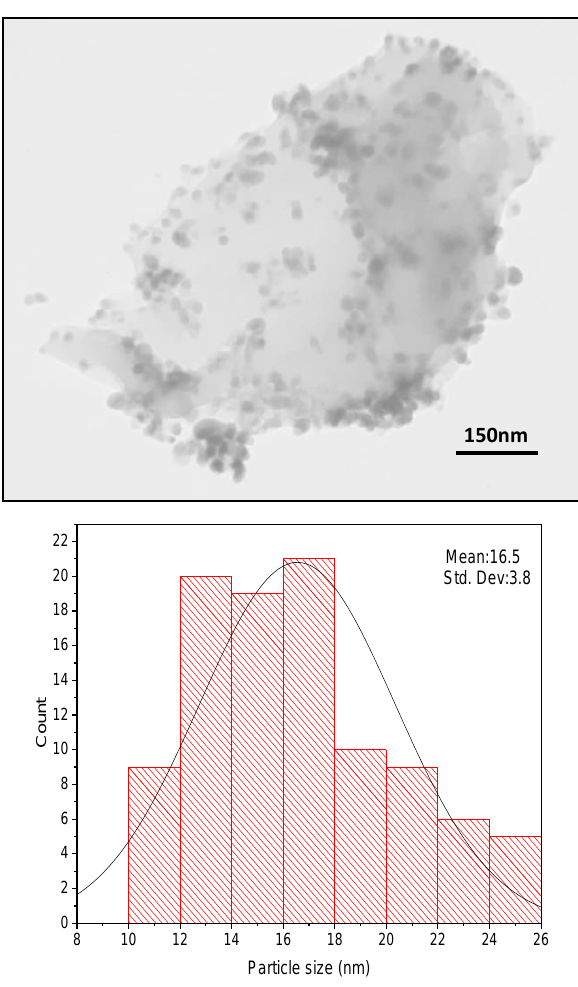
Figure 3. TEM image of catalyst.